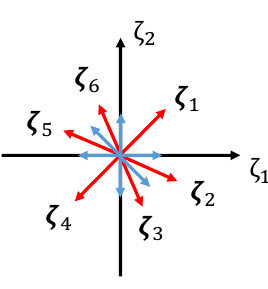
Figure 12 . Possible choices of the FI parameter (cid:16) . Each choice corresponds to a cone generated by two neighboring short (blue) arrows. Representatives from the cones are the long (red) arrows and are denoted by (cid:16) i ( i = 1 ; : : : ;